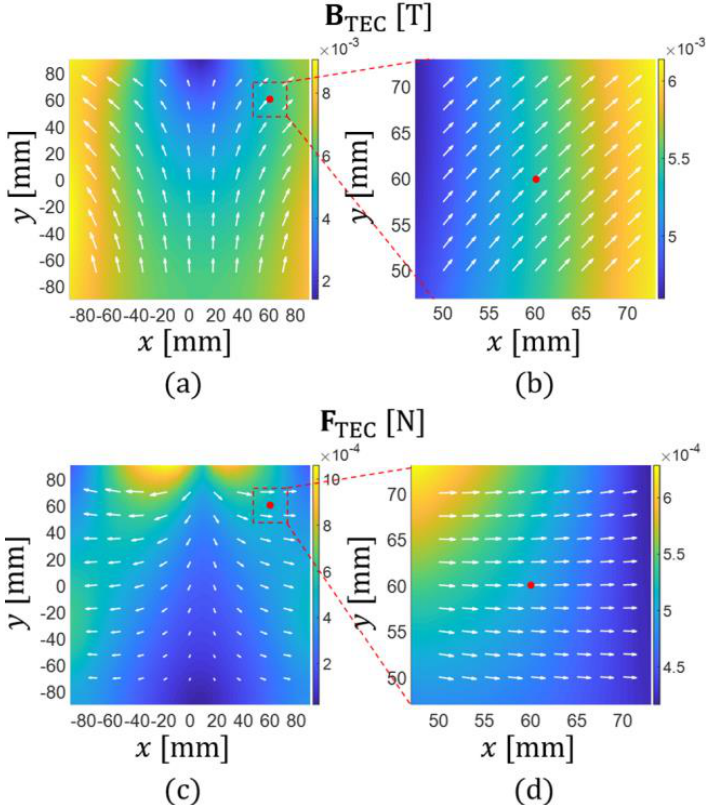
Figure 5. ( a , b ) The distribution of the magnetic field inside the TEC; ( c , d ) the corresponding magnetic force generated to apply a magnetic force of ( F 0 , α F ) = ( 500 µ N, 0 ◦ ) to the microrobot located at x = [ 60 mm, 60 mm,0 ] T . In this case, the optimal α B is approximately 45 ◦ .